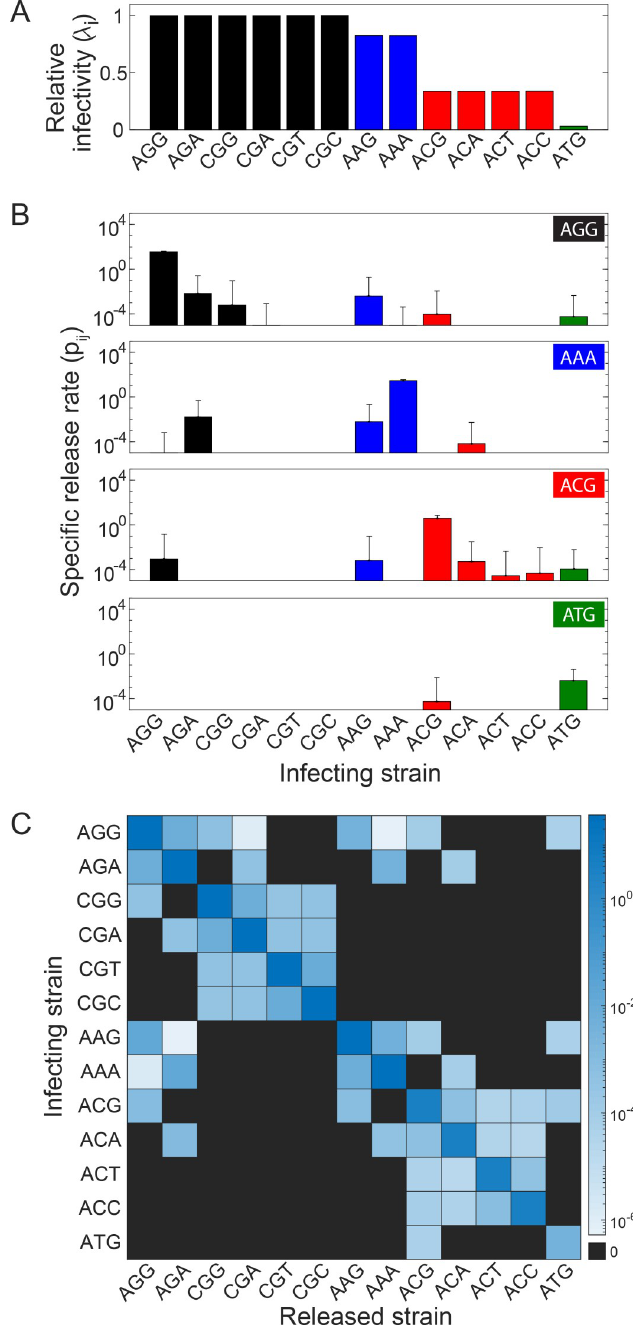
Fig 3. Relative infectivity and specific release rate. (A) Relative infectivity of strains carrying different codons obtained from stochastic simulations. The codons are color coded by the amino acids they encode (see inset of Fig 2B). (B) The average rate at which virions carrying different codons are released following infection with a virion carrying particular codons mentioned in the panels. Estimates for the remaining infecting strains are in S3 Fig (C) A heat map displaying the specific release rate estimated in (B) and S3 Fig compactly. The actual values are in S1